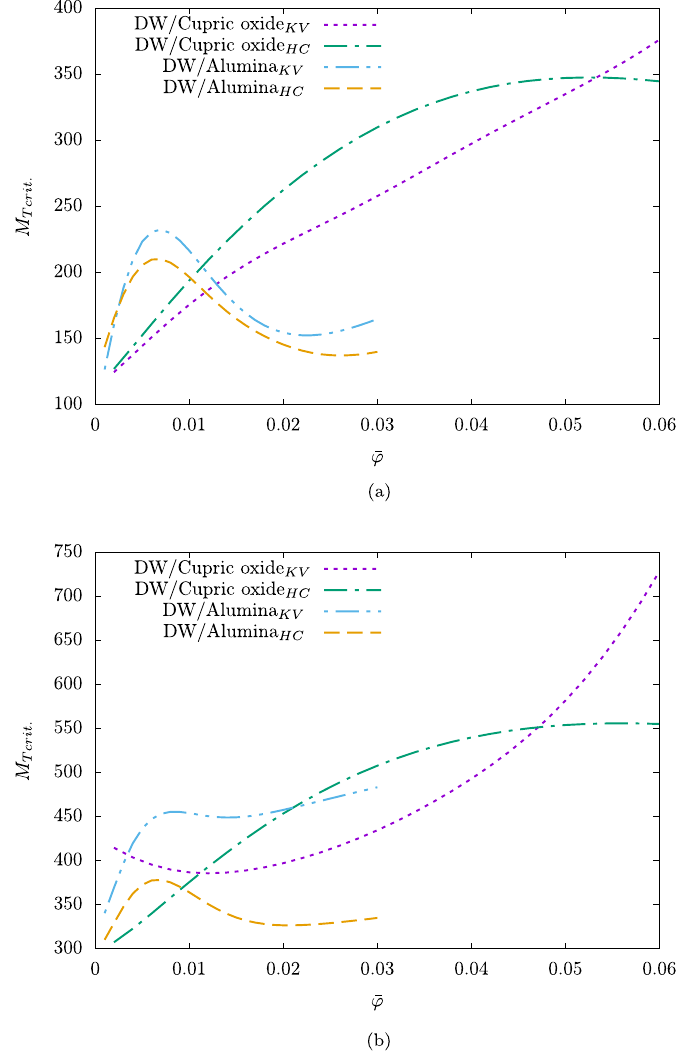
Figure 5: The stability boundaries of critical temperature Marangoni numbers for DW/alumina and DW/cupric oxide nano fl uids for , using the thermal conductivity and dynamic viscosity constitutive functions proposed by Brinkman - Hamilton - Crosser and Khanafer and Vafai based on ( a ) Model I and ( b ) Model